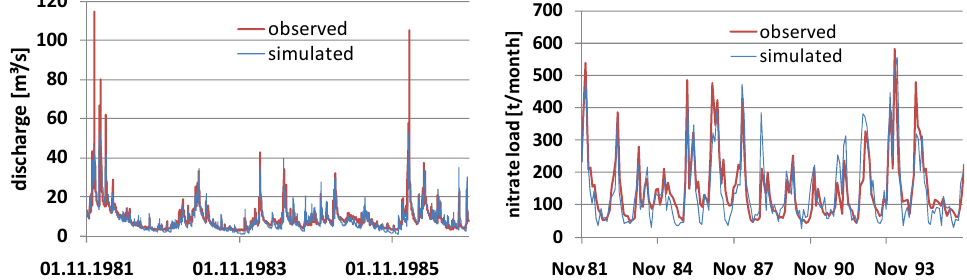
Fig. 2. Simulated and observed time series of daily discharge (left) and monthly nitrate load (right) at gauge Leineturm.